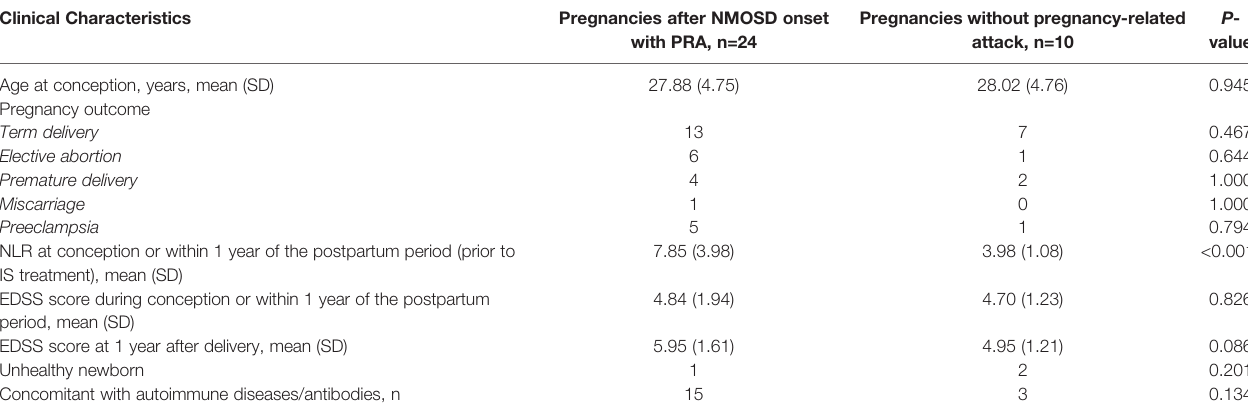
TABLE 4 | Comparison of clinical characteristics and the outcomes between NMOSD patients with and without pregnancy-related NMOSD attack. Clinical